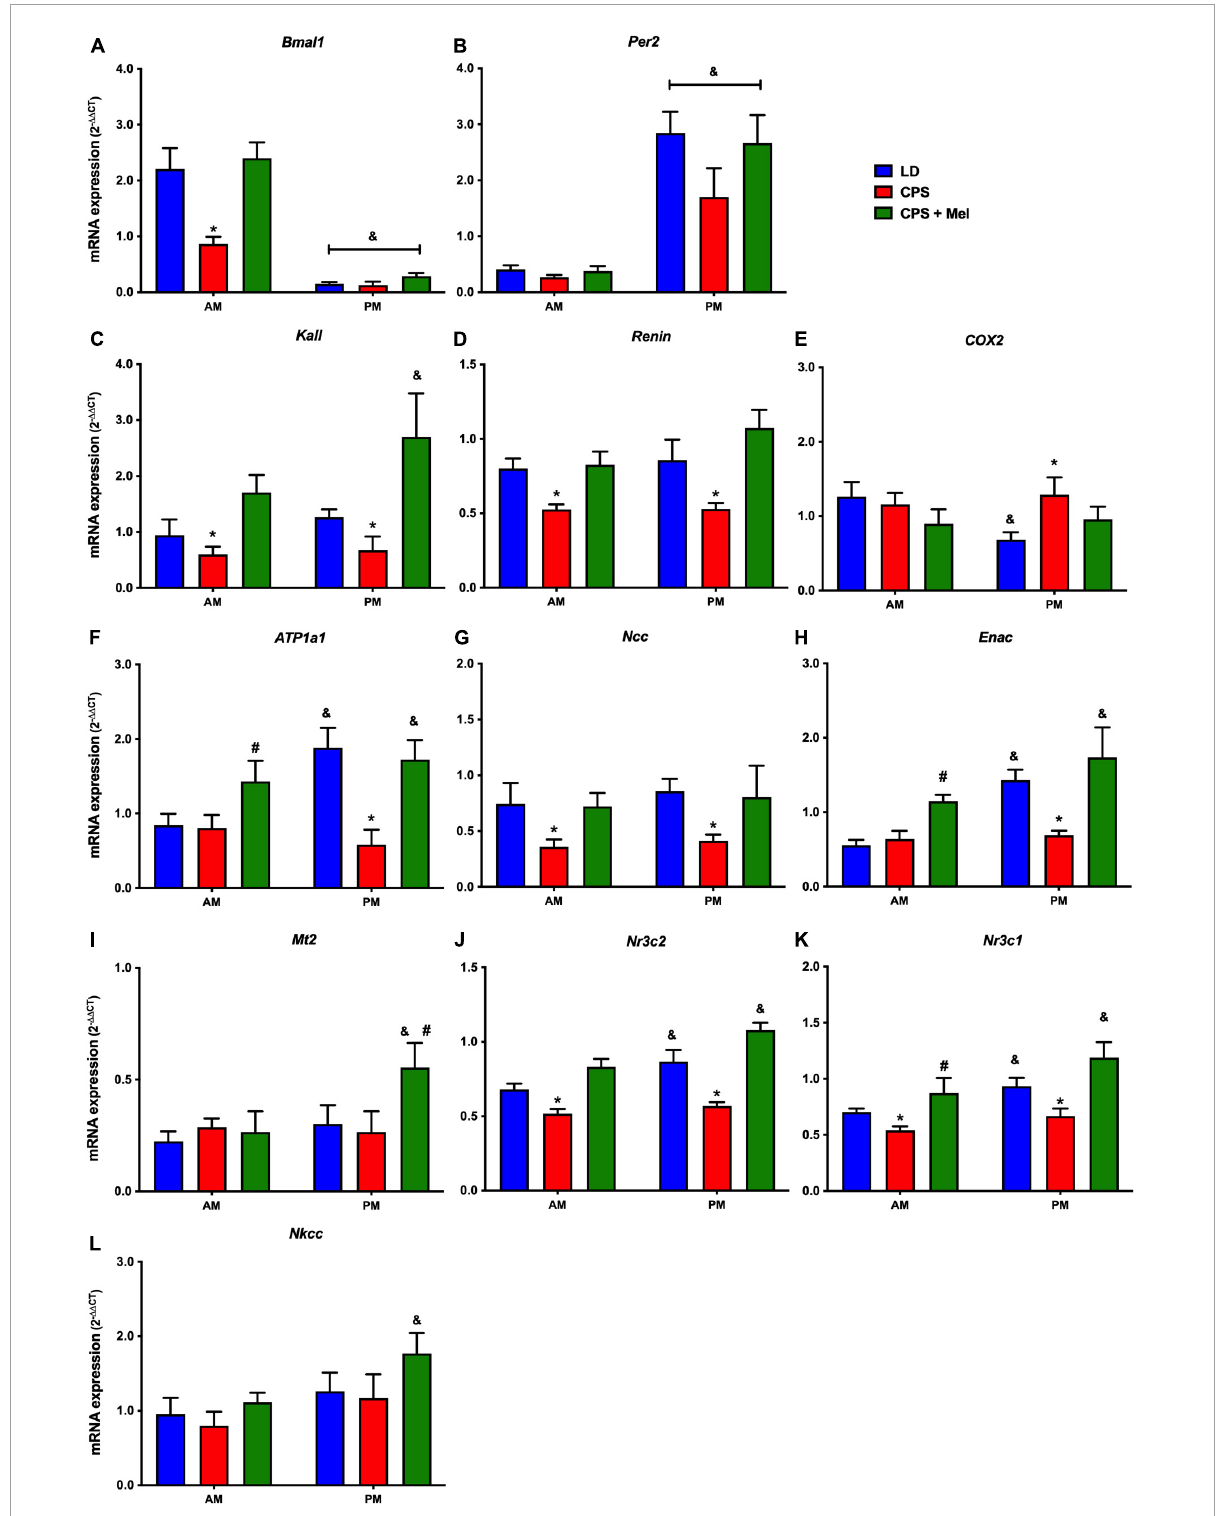
FIGURE5 Gene expression in the kidney from adult female offspring. The whole kidney was collected at 11 and 23 h ( n = 6–7 per clock time) in females gestated in LD (blue bars), CPS (red bars), and CPS + Mel (green bars) conditions. Data are mean ± SEM. *Different to LD and CPS + Mel, # Different LD to CPS (two-way ANOVA and Tukey). & Different to AM period (unpaired t -test; two-way ANOVA, and Tukey). Significant differences were ser when p <